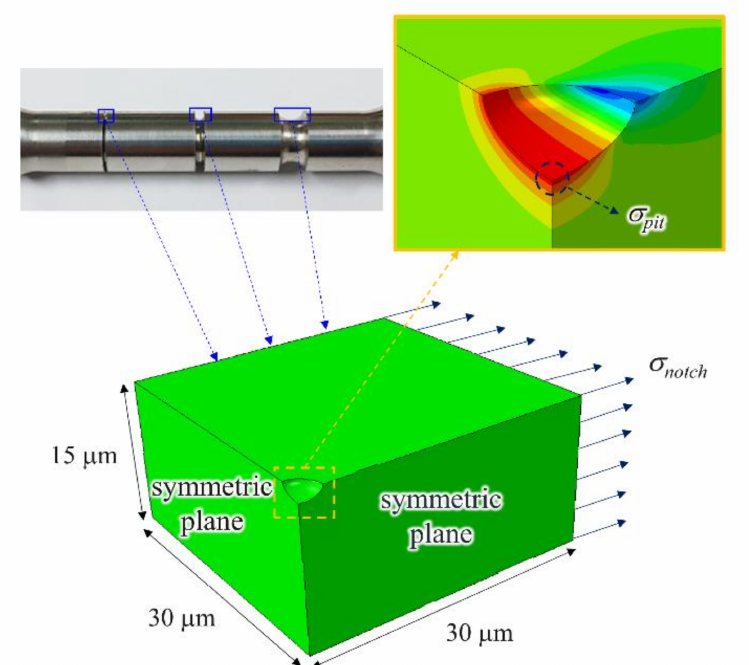
Figure 7. FE model to calculate the maximum principal stress in the local pit, σ pit